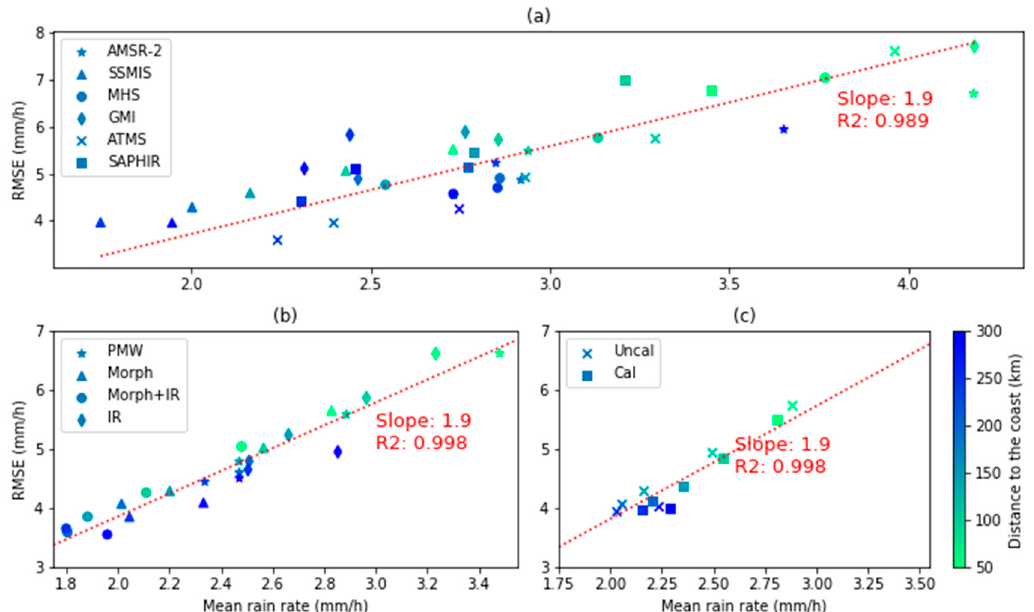
Figure 11. The scatter plot of RMSE and mean rain rate of the hit data of 12 IMERG estimates according to different distances to the coast. ( a ) indicates six individual PMW estimates, and ( b ) demonstrates four multi-satellite estimates for the second level of evaluation, among the merged PWM, morphed PWM, the mixture of morphed PMW and IR, and IR-only estimates, and finally ( c ) shows the multi-satellite estimates with and without gauge calibration.